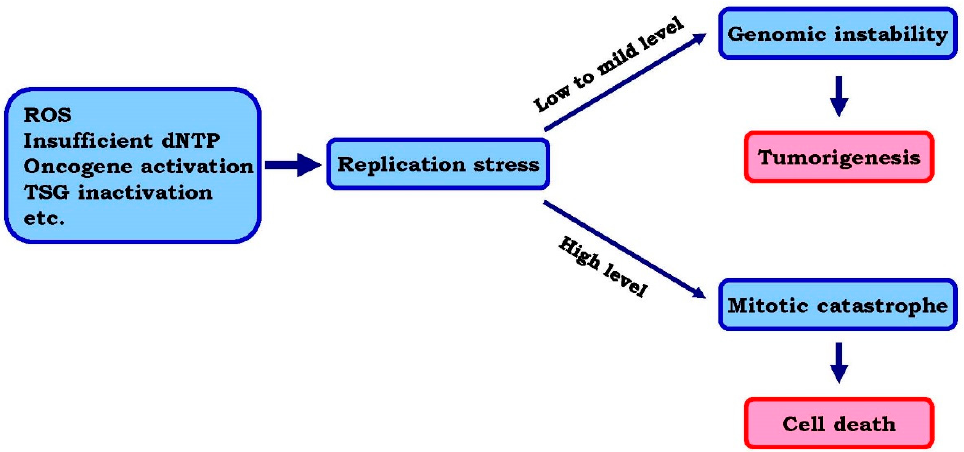
Figure 1. Rationale for enhancing replication stress to kill cancer cells. DNA replicative stress can be induced by various factors including ROS, insufficient dNTP, oncogene activation or the loss/inactivation of tumor suppressors, etc. At the low to mild level, the replicative stress predominantly induces genomic instability, therefore facilitates tumorigenesis and cancer progression. However, when the replicative stress is enhanced to a high level through further loss of checkpoints, cancer cells may enter the mitotic phase with incomplete or uncorrected DNA replication, which eventually leads to cell death through mitotic catastrophe. Therefore, enhancing replicative stress can be a novel approach to kill cancer cells. TSG: Tumor suppressing gene.